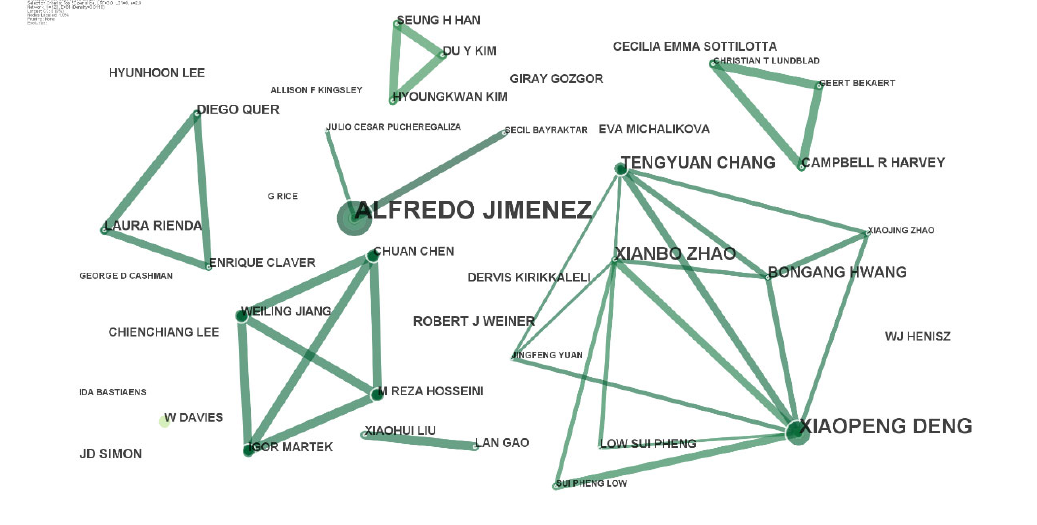
Fig . 5. Author collaboration graph of political risk related papers in